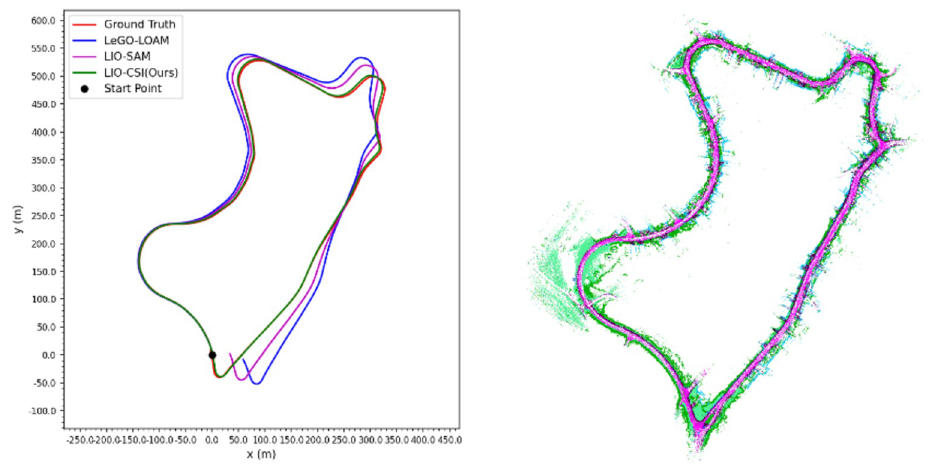
Fig 10. Trajectory comparison and semantic maps of sequence 09.